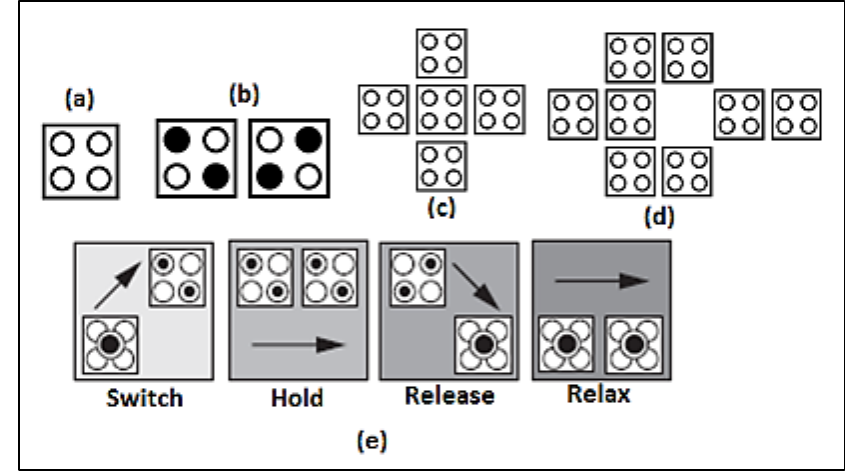
Figure 1. (a) One QCA Cell (b) Two States of Logics respectively from left to right : 0 , 1 (c) A Majority QCA design (d)